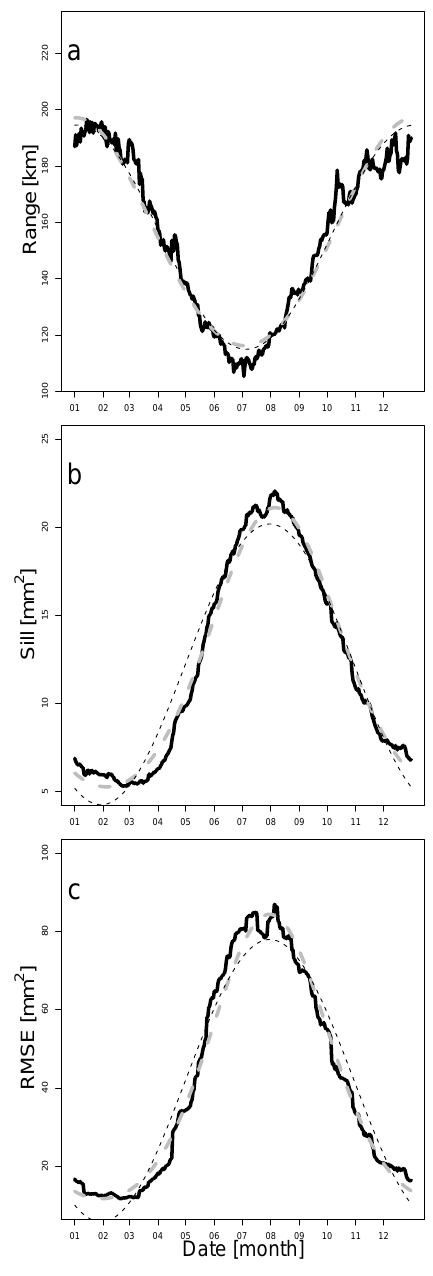
Fig. 7. Average daily variation of the range (a) , sill (b) and root mean square error (RMSE) (c) for each day of year. The solid lines are the estimated values, the black dashed lines the cosine functions fitted on the normal data and the grey dashed lines the cosine func- tions fitted on the sqrt-sqrt transformed